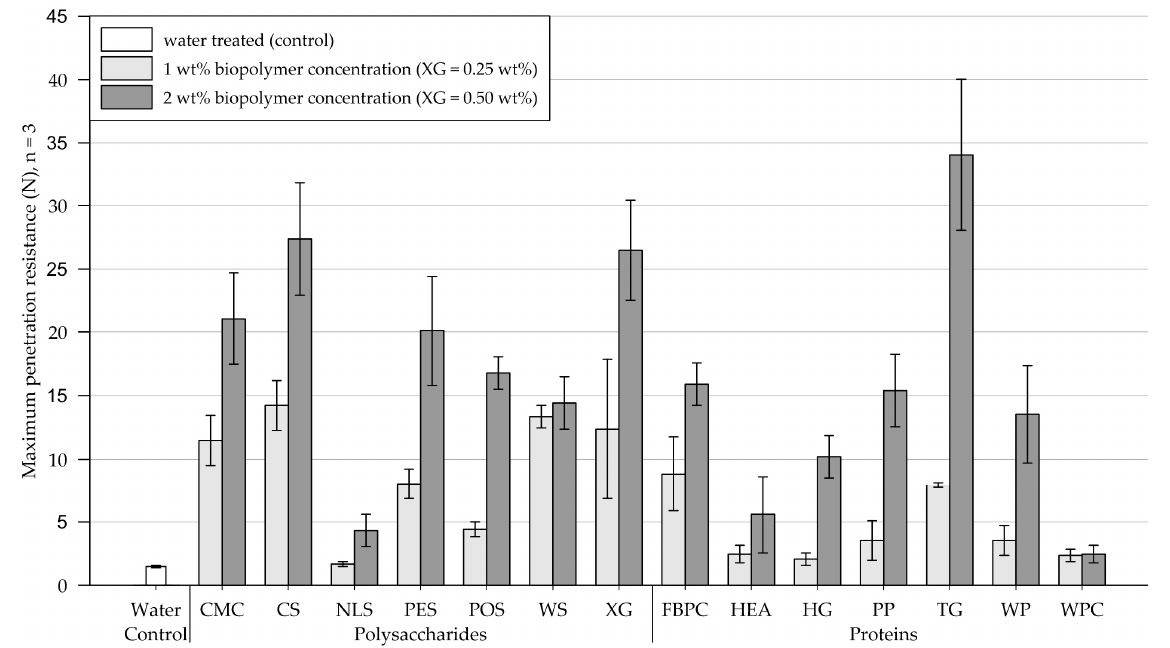
Figure 7. Mean maximum penetration resistance of crusts from medium-grained sand samples measured by penetrometer tests. Biopolymers are grouped into polysaccharides and proteins with water as control. Tests were performed in triplicates ( n = 3), with error bars indicating the standard deviation (SD). Note. The exact values of experimental results are appended in Table A3.